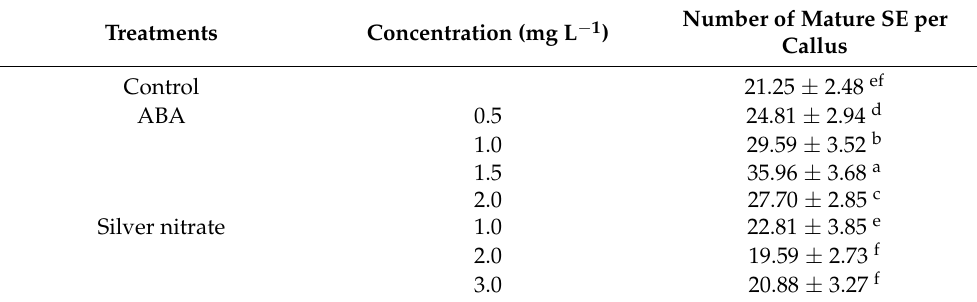
PRGs: plant growth regulators; Data were obtained from three independent experiments ( n = 27), where values represent means ± SD. Means followed by the same letter in the column are non-significantly different by DMRT ( p =